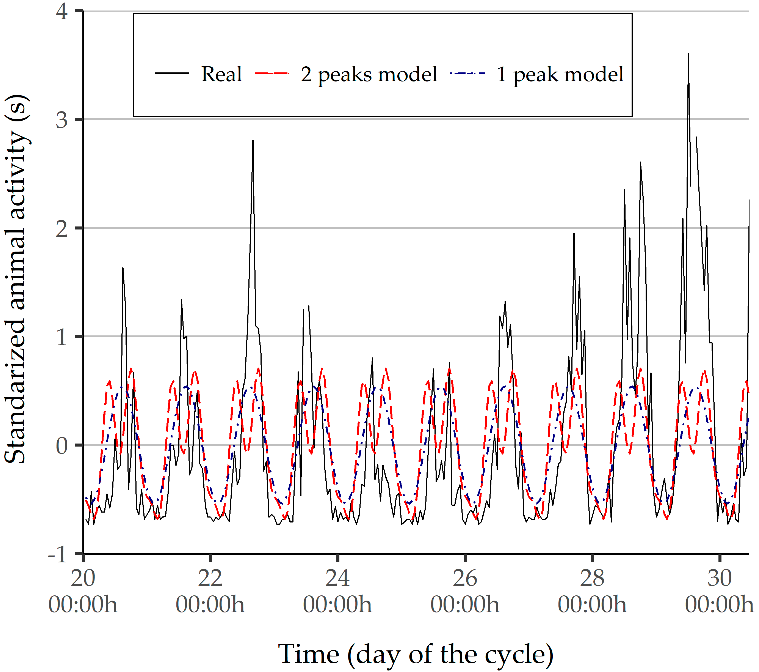
Figure 6. Comparison of the standardized hourly activity between the 1-peak model and the 2-peak model of C6.